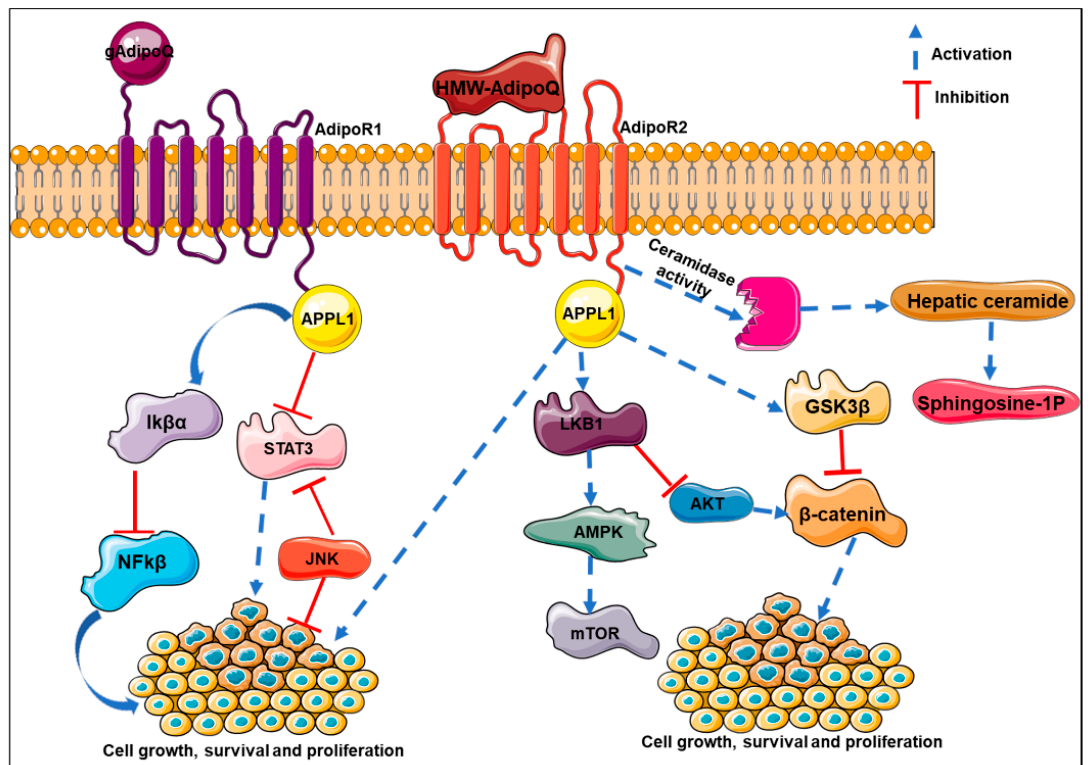
Figure 2. Adiponectin modulates various signaling mechanisms to inhibit caner growth.